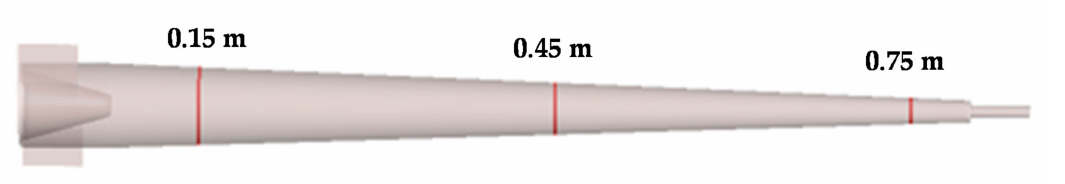
Figure 4. Location of the study lines carried out along the cyclonic separator.